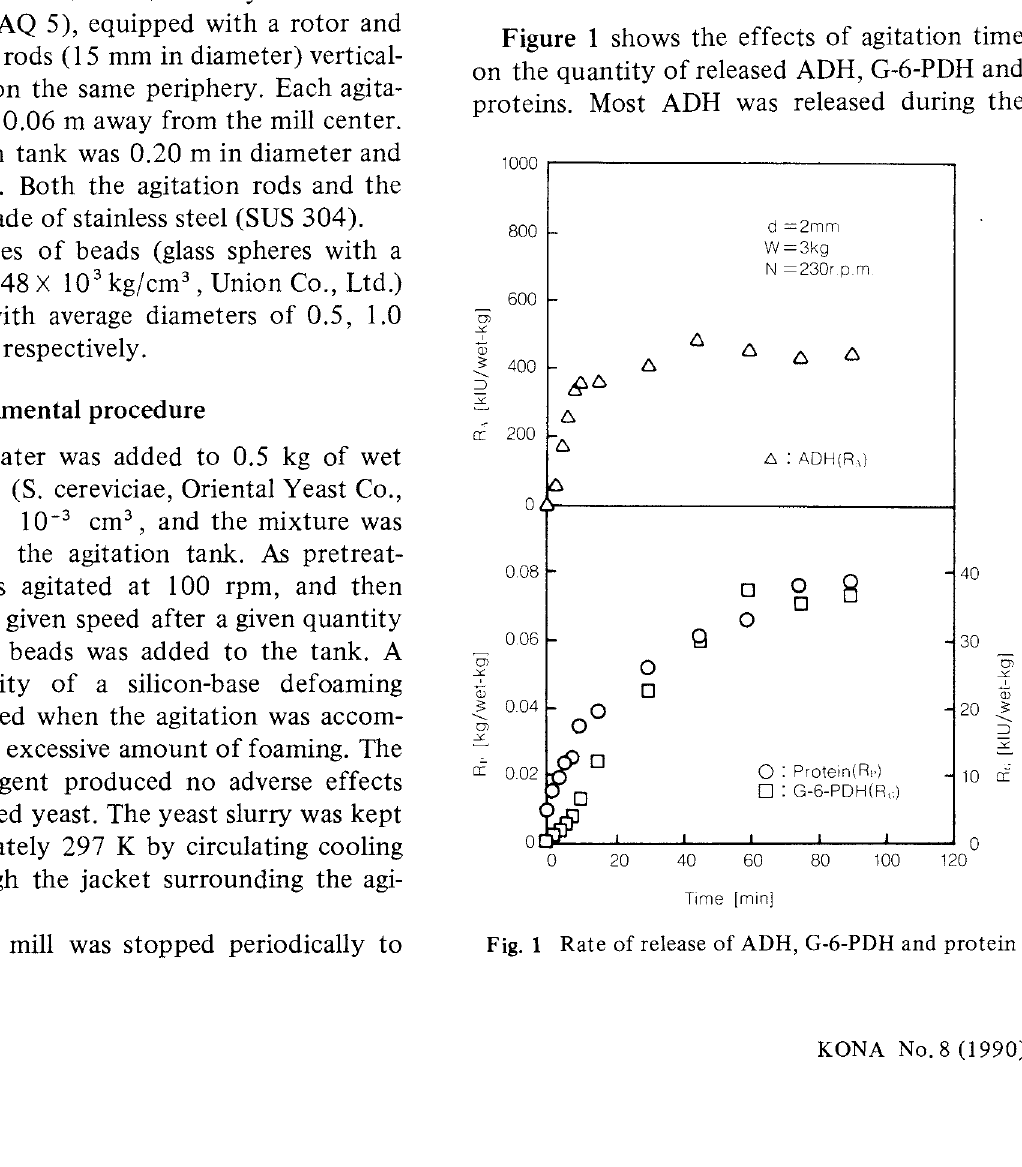
Fig. 1 Rate of release of ADH, G-6-PDH and protein